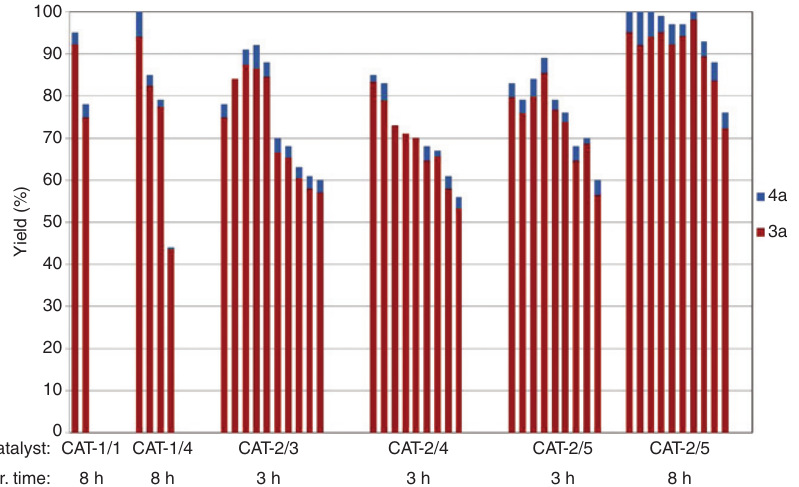
Figure 5: Selectivity and recyclability of catalysts in aminocarbonylation carried out in acetonitrile [0.2 mmol 1 , 0.5 mmol 2a , 0.25 mmol Et N, catalyst (with 3.6 μ mol Pd-content), 1 ml acetonitrile, 30 bar CO, 100 ° 3